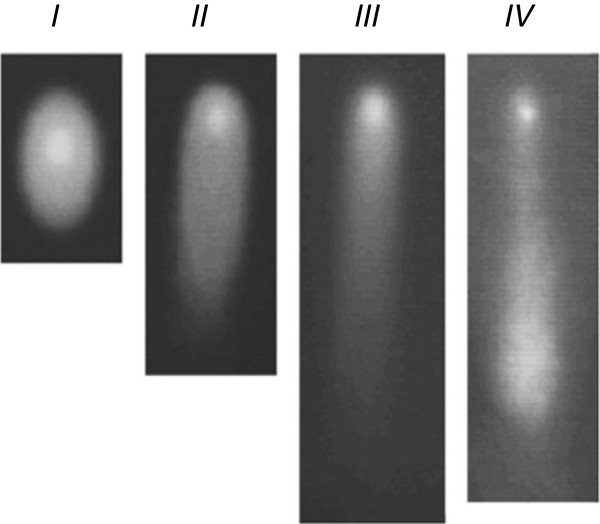
Image of the characteristic classes of comets (representing intact and damaged DNA) are shown ex vivo for circulating leucocytes [35].